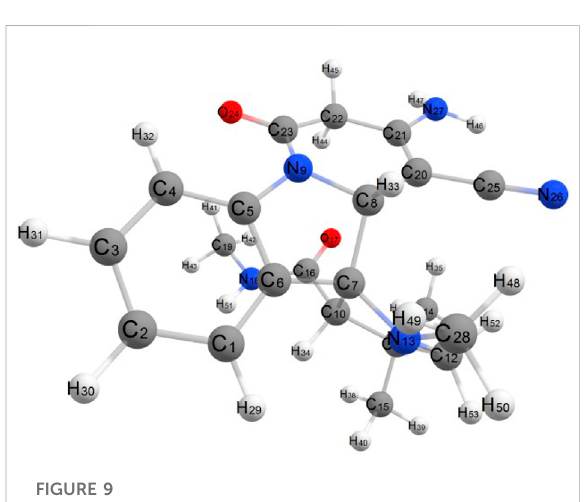
FIGURE 9 Optimized molecular